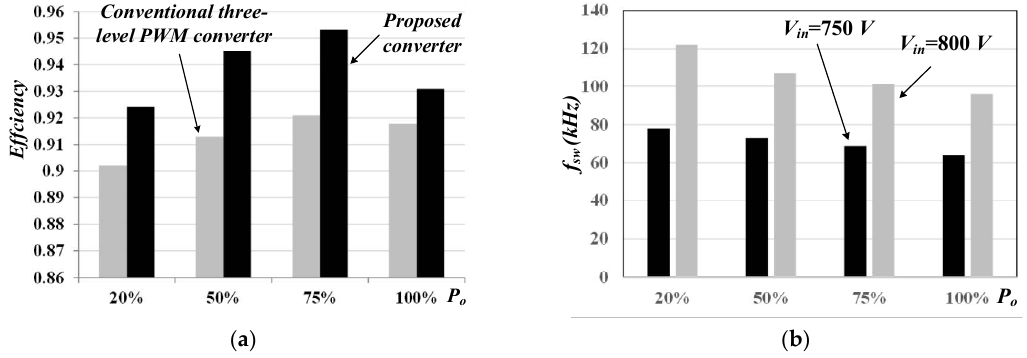
Figure 13. Test results ( a ) circuit efficiency compared to the conventional three-level PWM converter; ( b ) switching frequency.